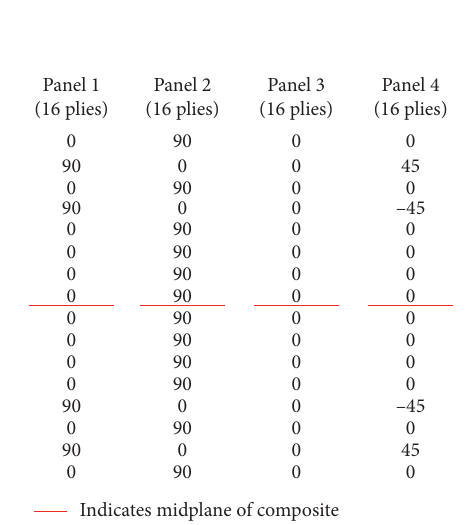
Figure 1: Layout details of the four composite